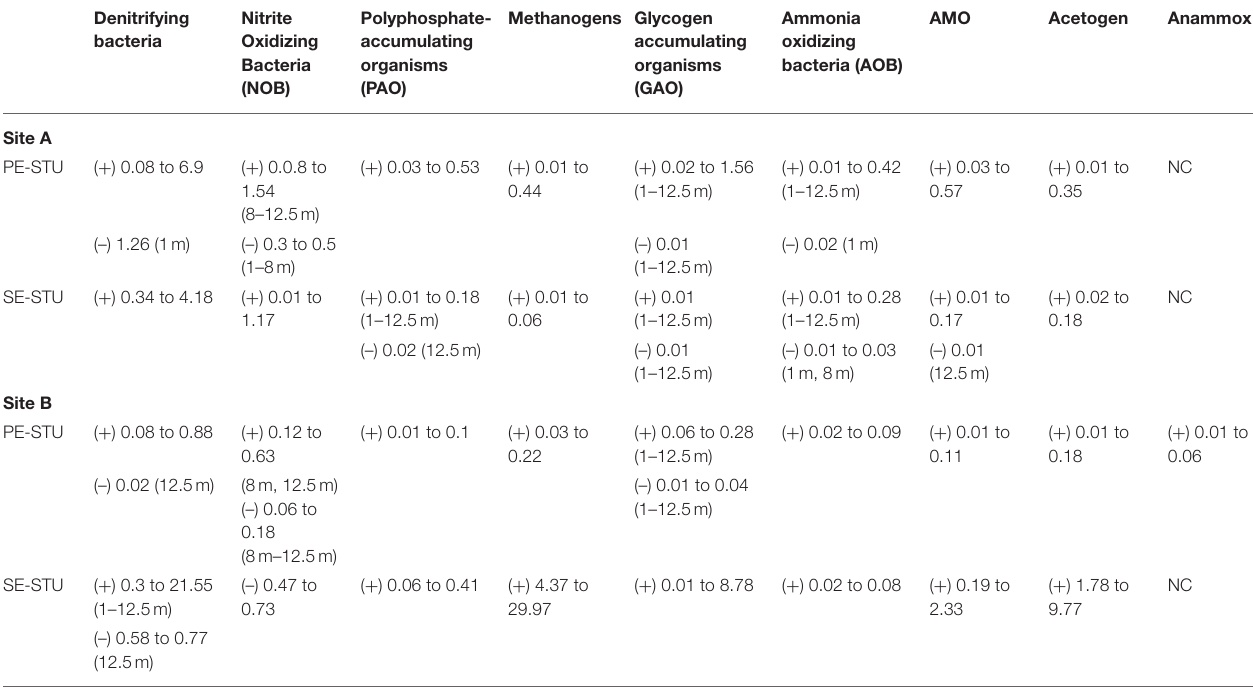
TABLE 6 | Key changes ( + /–, NC; “No Change”) in relative abundance of functional groups in respect of control subsoil samples. Denitrifying